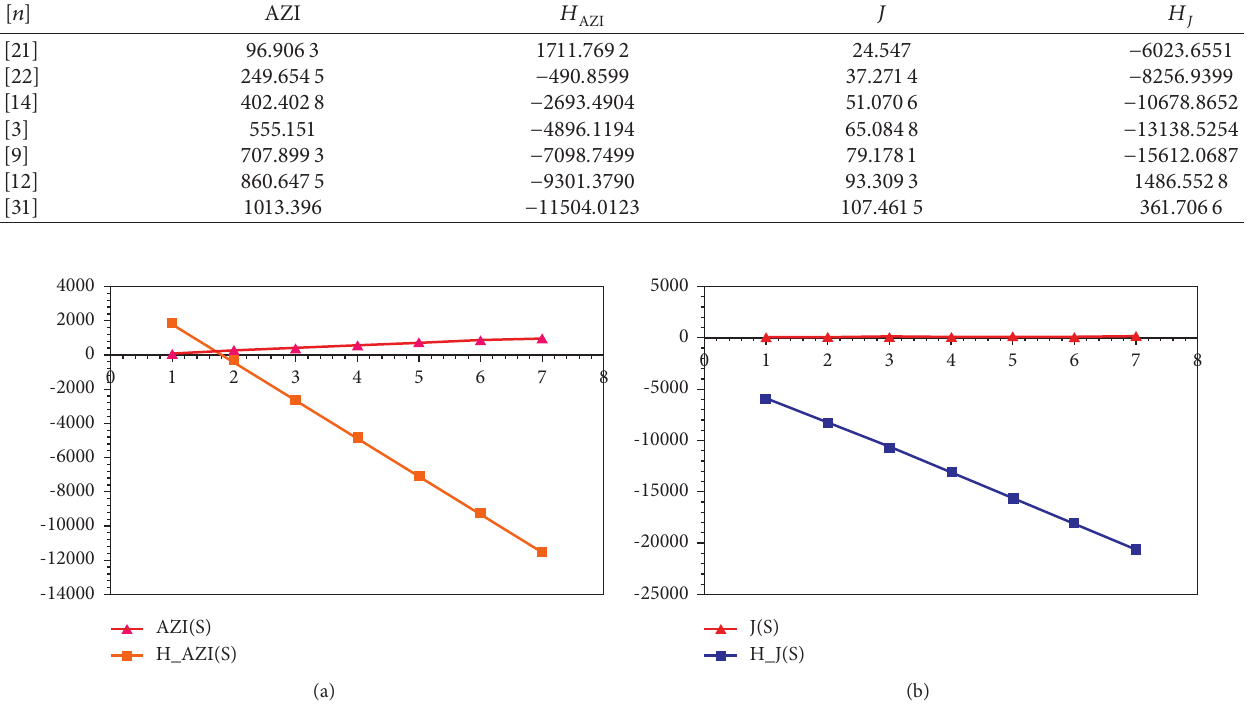
Figure 8: (a) The augmented Zagreb index with heat of formation. (b) The Balaban index with heat of